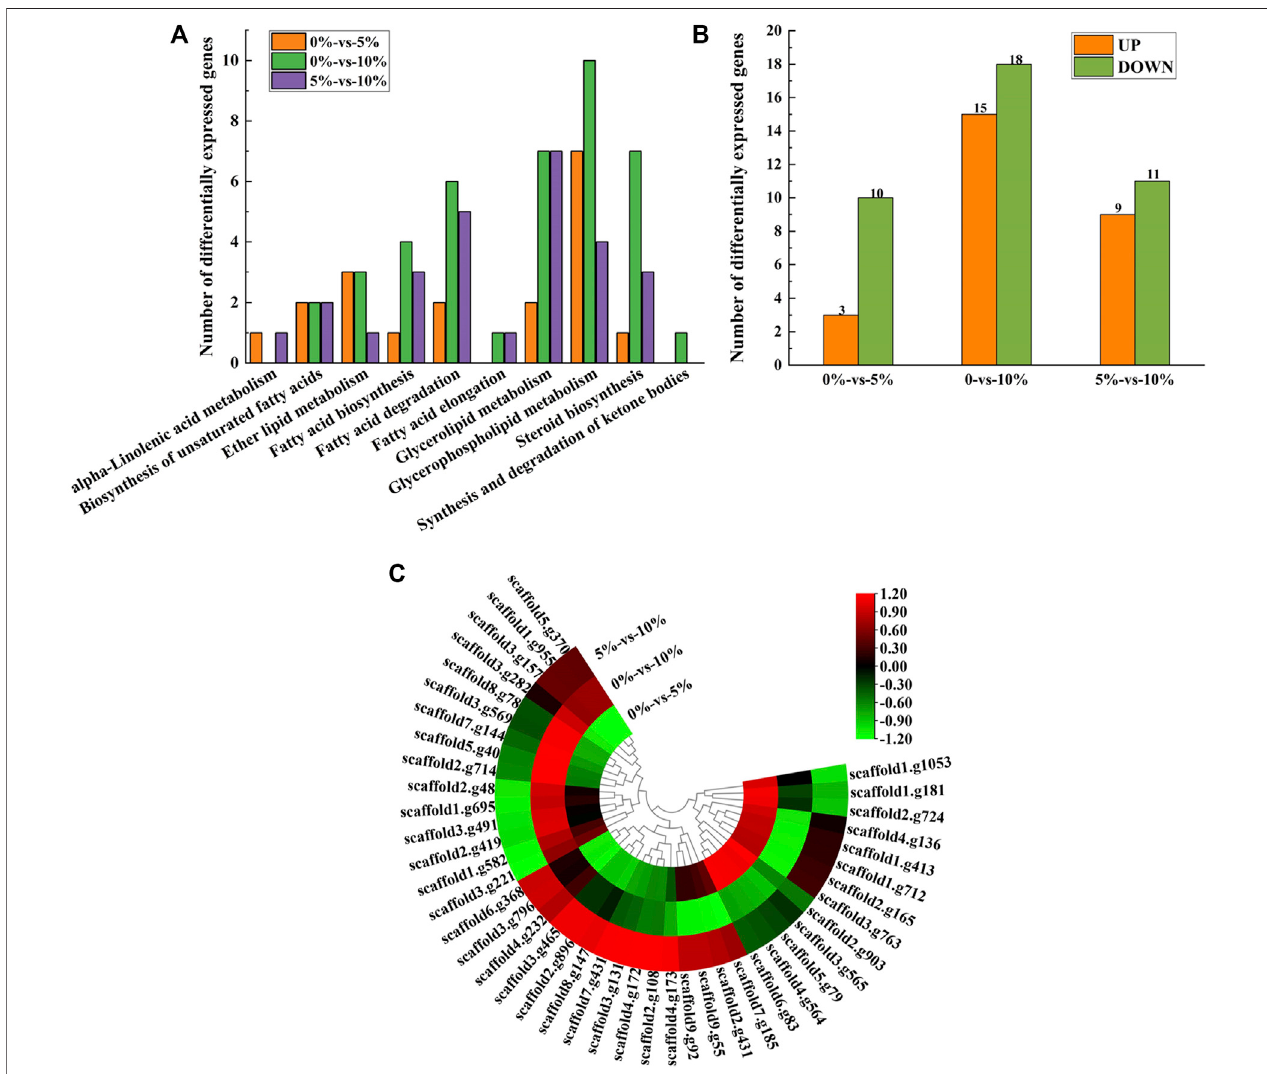
FIGURE 2 | Transcriptome analysis of lipid metabolism. (A) Expression of differentially expressed genes at 0, 5, and 10% NaCl; (B) Enrichment of pathways under different NaCl stress; (C) Heatmap of differentially expressed genes.